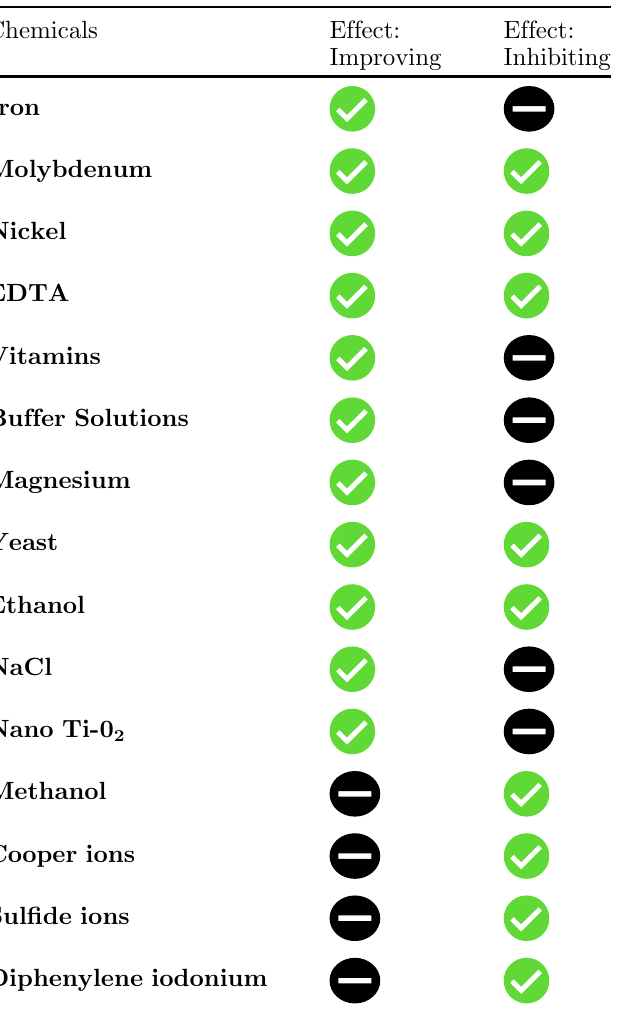
Table 8. Effect of chemicals in photo fermentation